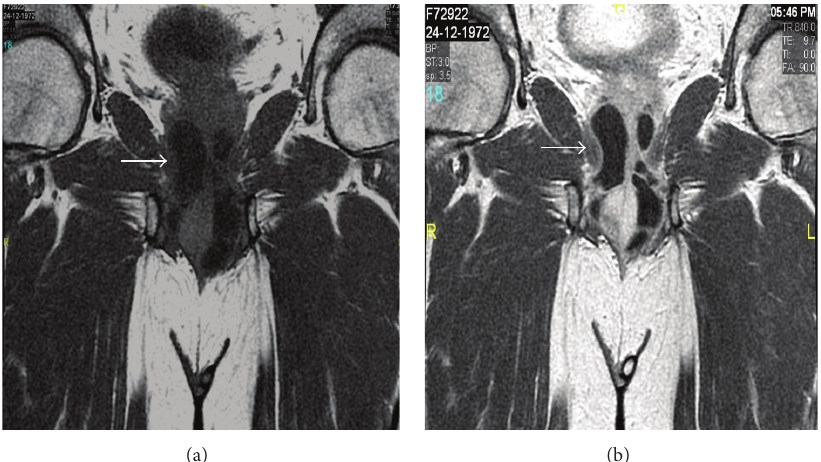
Figure 3: Coronal pre- (a) and post- (b) contrast T1WI images showing thick enhancing wall and septations of the cystic structures—infected giant sized Cowper’s